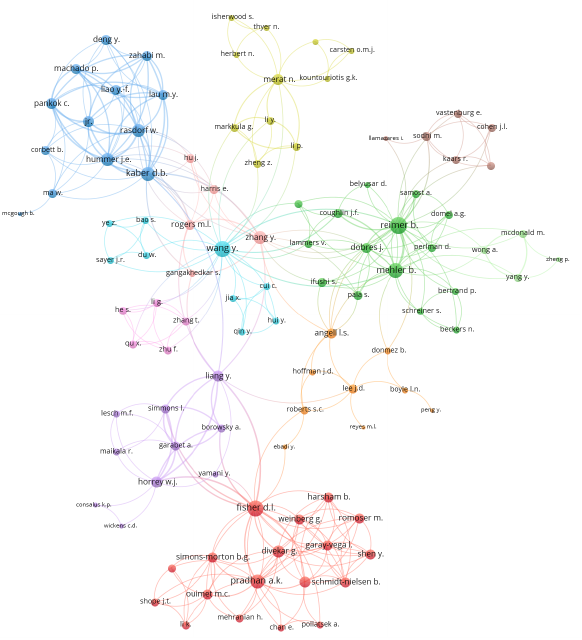
Figure 6. Largest cluster of